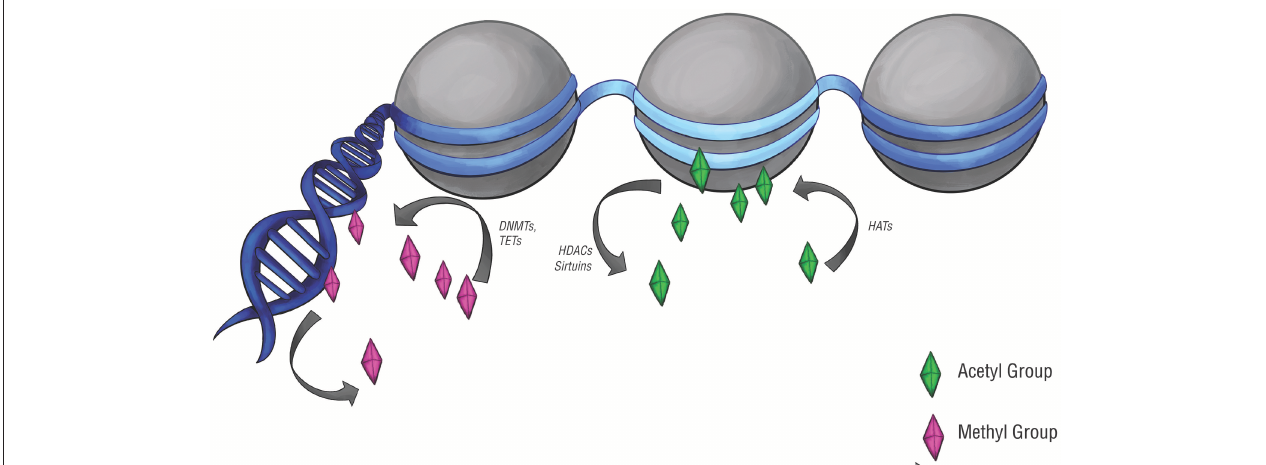
FIGURE 2 | Epigenetic modifications and regulators. Epigenetic modifications are carried out by a set of specialized enzymes that act directly on DNA or on the histones around which chromatin is wrapped. Histone acetyltransferases (HATs) place acetyl groups on chromatin, while histone deacetylases (HDACs) and sirtuins do the opposite. Acetylation of histones typically upregulates gene expression, denoted here by the light blue region of DNA. DNA methyltransferases (DNMTs) and ten-eleven translocation enzymes (TETs) can alter the level of DNA or histone methylation, which typically downregulates gene expression. This is denoted by the navy-blue regions of DNA.